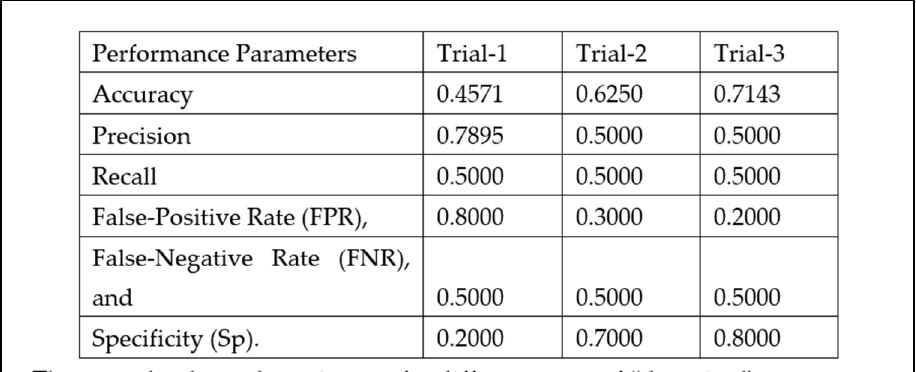
Figure 29. Test results—”event detection”